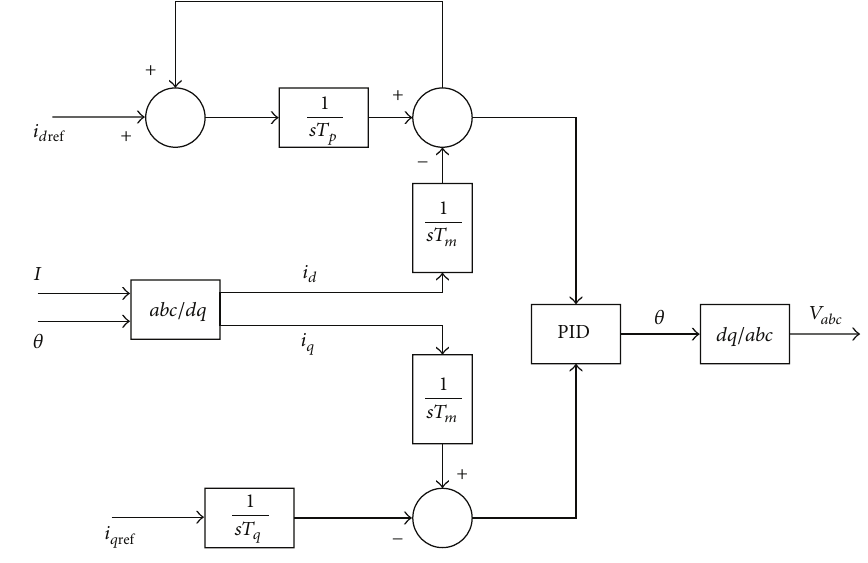
Figure 11: Inverter control system.